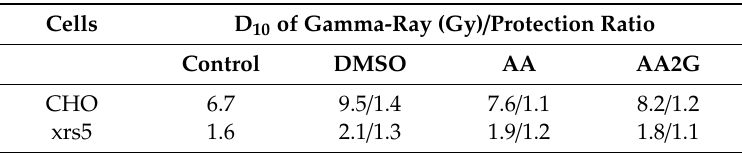
Table 1. D 10 values and protection ratio of